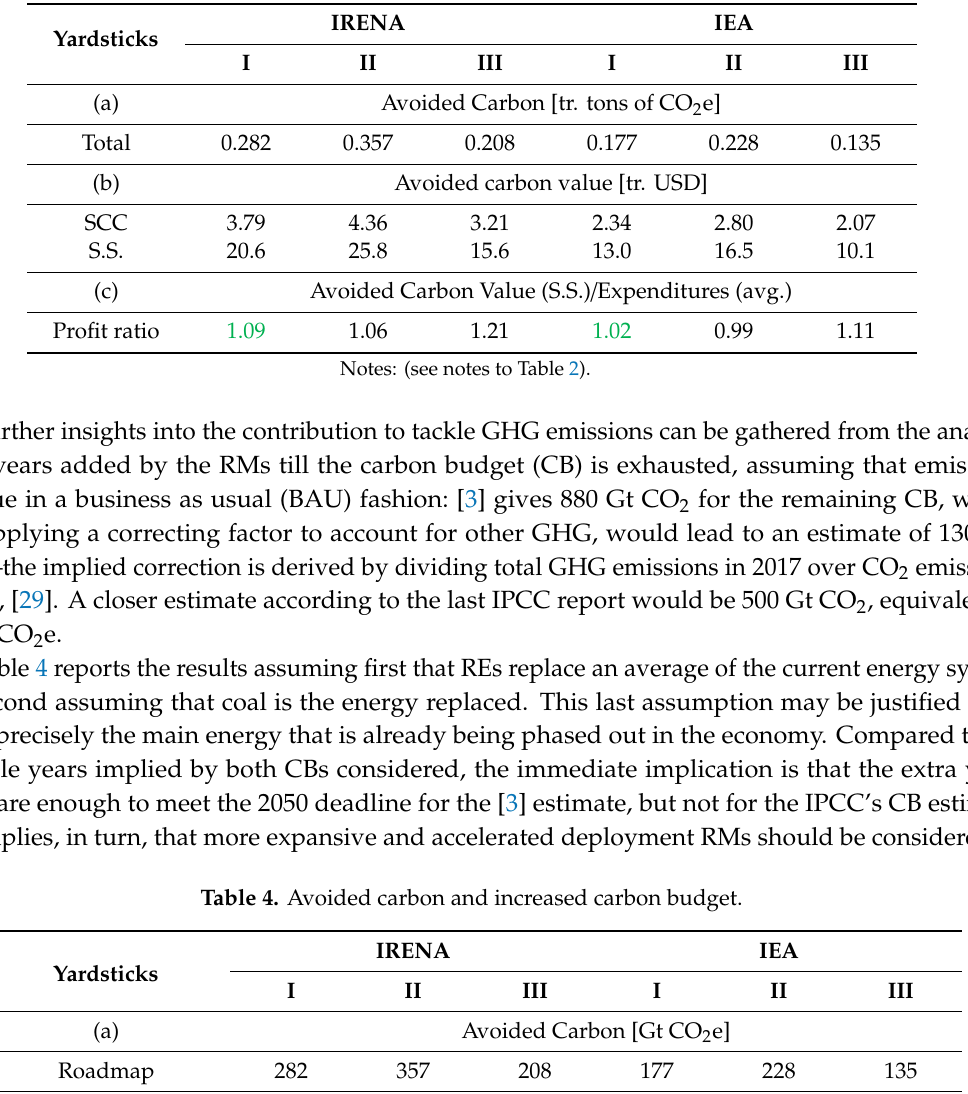
Table 3. Avoided Carbon (AC) and avoided crabon value (ACV).